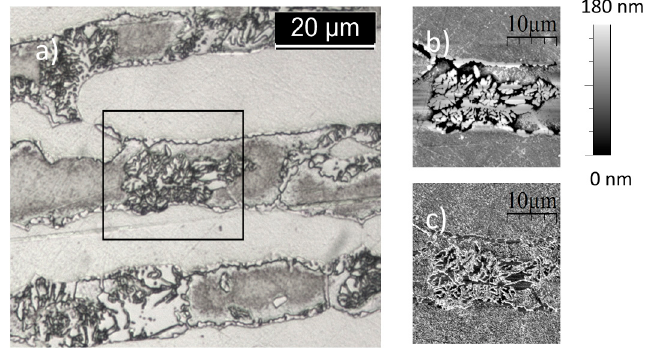
Figure 8. ( a ) Optical image of sigma phase for S3 (black rectangle). ( b ) Atomic Force Microscopy (AFM) image—height signal—of the previous sigma grain ( c ) AFM image (phase signal) of the previous sigma grain. Indents have been performed on the dark grey grains of this last image. White rectangles in the optical images (left ones) mark the zone where AFM images have been obtained (right ones).